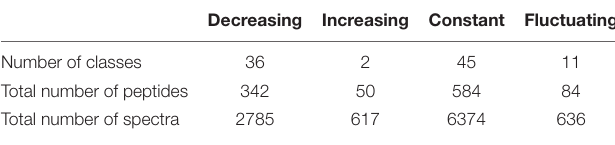
TABLE 4 | Characteristics of the kinetic